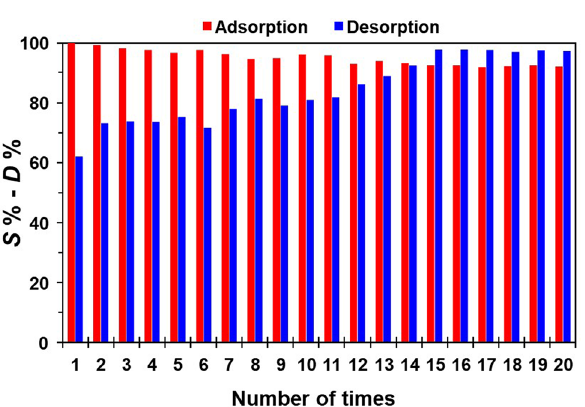
Figure 2. Pd(II) adsorption and desorption cycles using 1 -EIR. Adsorption conditions: [ 1 -EIR] = 0.1 g; [Pd(II)] = 100 ppm (= mg L −1 ); [HCl] = 0.1 M; shaking speed = 280 rpm; shaking time = 3 h.